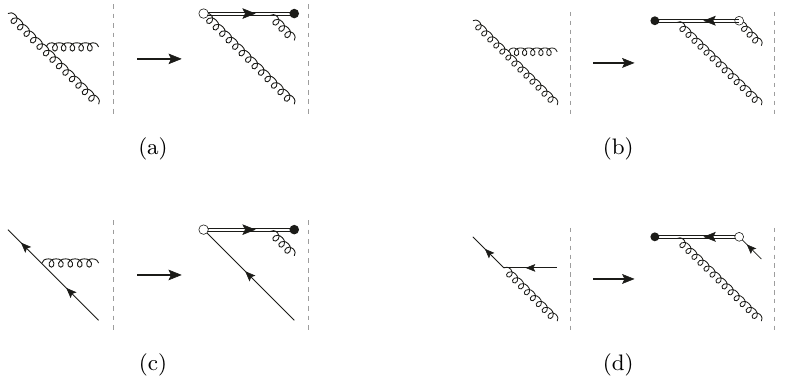
Figure 6 . Rules for obtaining graphs with eikonal lines in Feynman gauge from the graphs in figures 3 to 5. The the top left line in each panel is an observed parton, a hold on the right of the final state